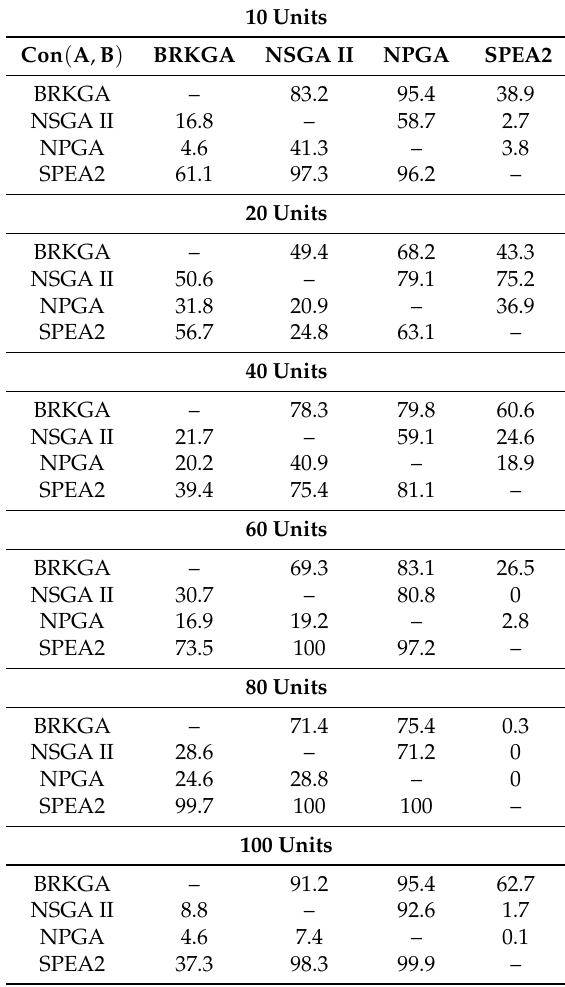
Table 15. Contribution measure